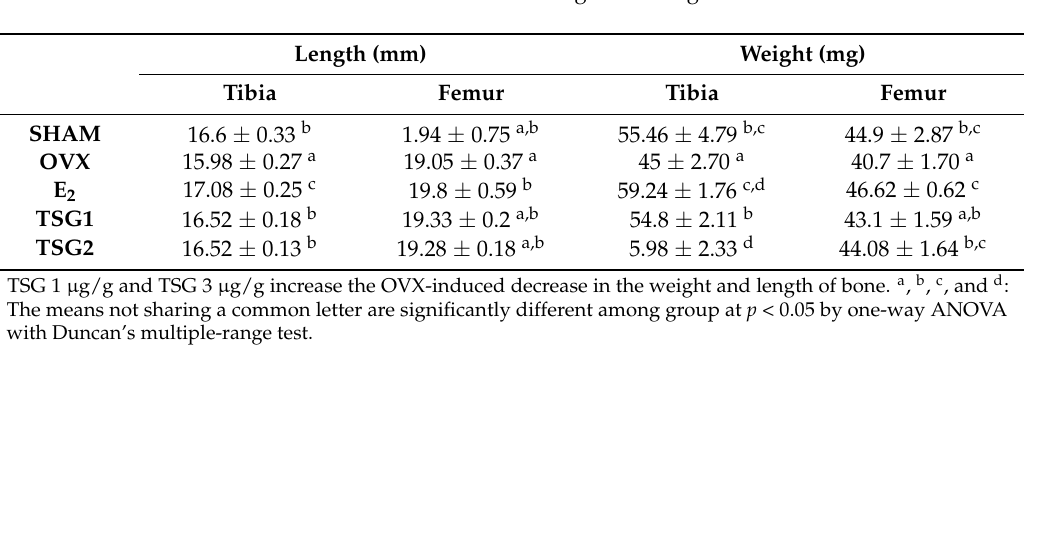
Table 2. The effect of TSG on the bone weight and length in OVX mice.